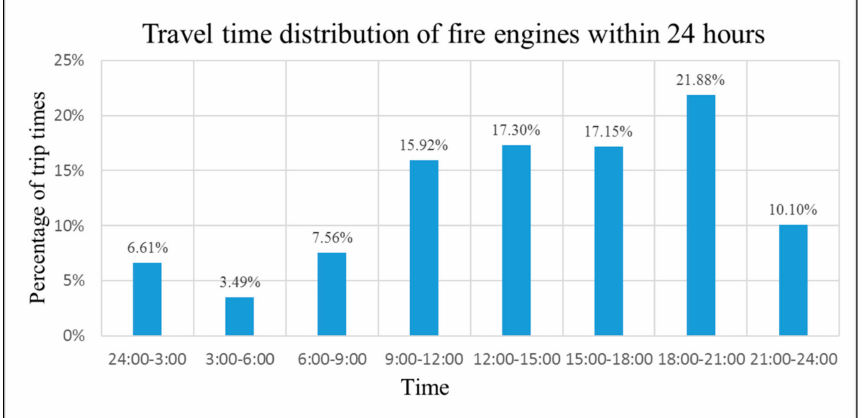
Figure 3. Travel time distribution of fire engines within 24